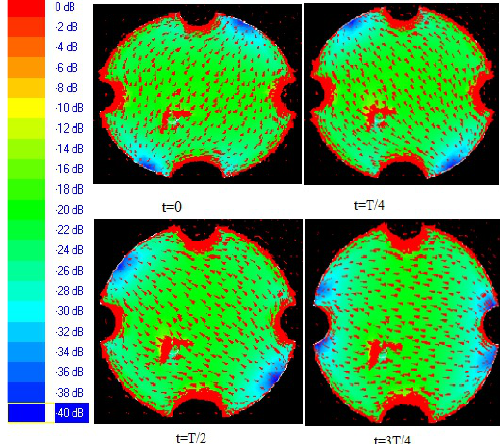
Fig. 12. The surface current distribution of the antenna at the resonant frequency of 5.37